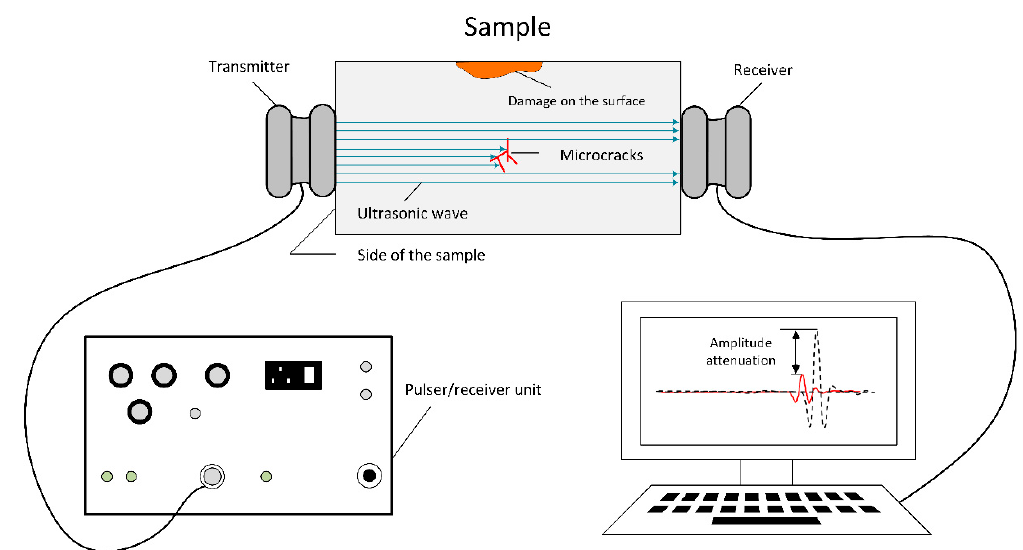
Figure 4. Schematic of ultrasonic transmission test.